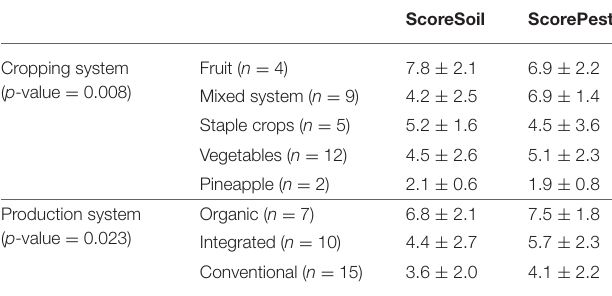
ScoreSoil ScorePest